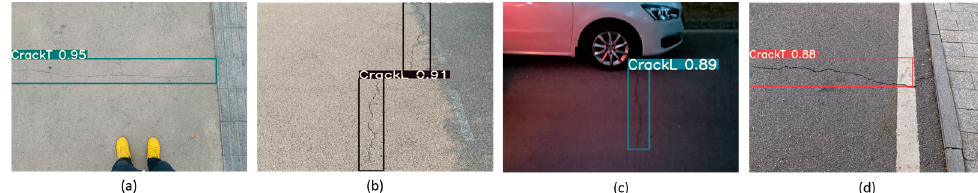
Figure 11. Outcomes of YOLOv5-based road crack detection: ( a ) Road crack I; ( b ) Road crack II: shadow; ( c ) Road crack III: dark light; and ( d ) Road crack IV: lane line.